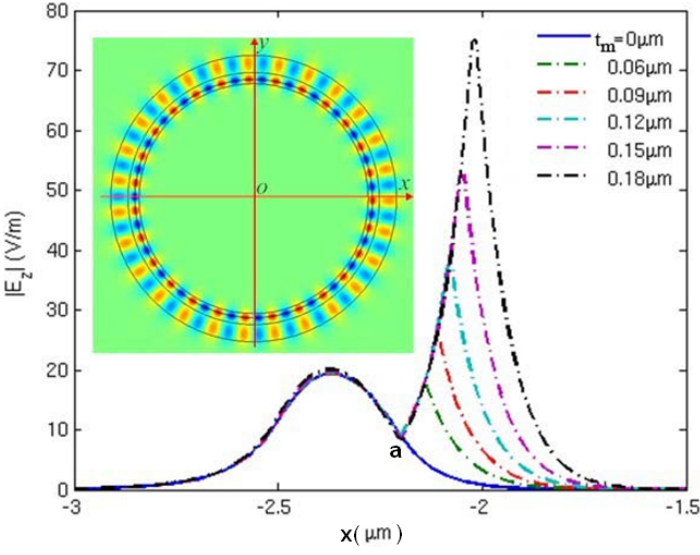
Figure 10. Electric field distribution along x axis from − 3 μ m to − 1.5 μ m for the metamaterial sensor operating in mode 27. The inset shows the electric field distribution of the sensor of t = 0.12 μ m